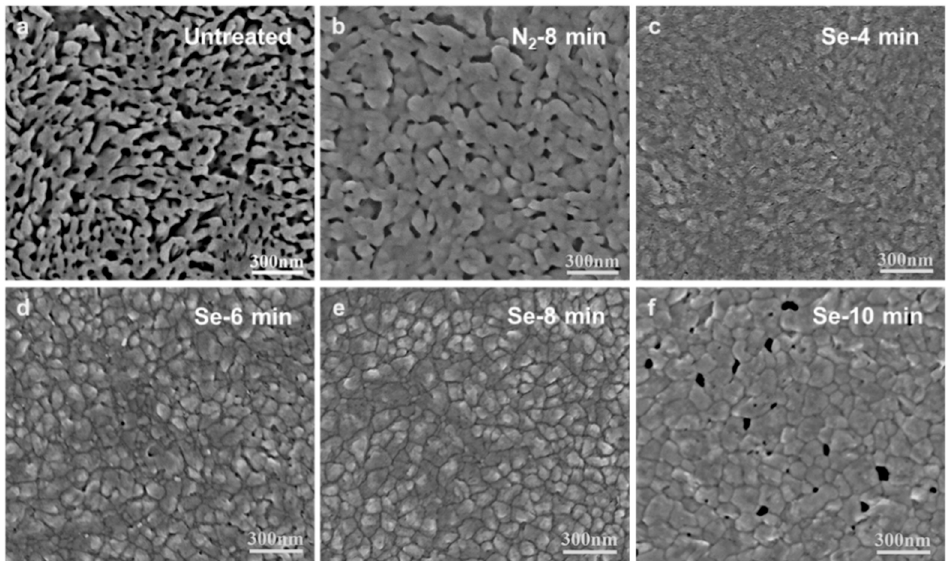
Figure 2. Analysis of surface morphologies of CuSbS 2 film: SEM micrographs of ( a ) the untreated film, ( b ) film annealed in N 2 for 8 min, and selenized films for ( c ) 4 min, ( d ) 6 min, ( e ) 8 min, and ( f ) 10 min.